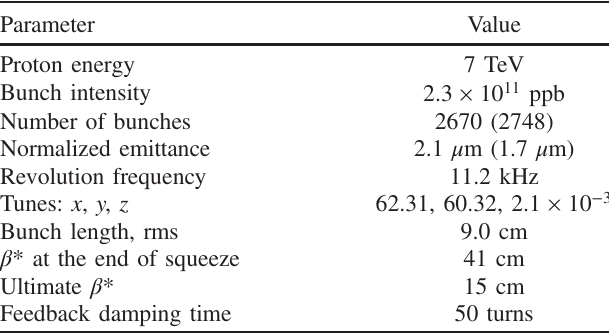
TABLE I. Key parameters of HL-LHC, considered for numeri- cal simulation in NHT for the standard and Batch Compression Merging and Splitting (BCMS) (in parenthesis) proton beams.